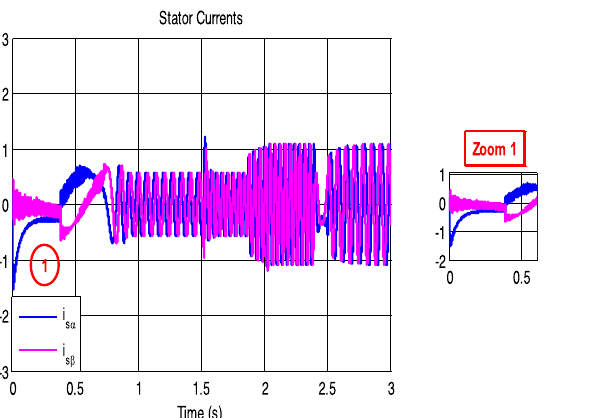
Fig. 19 FL-DTC estimated speed response